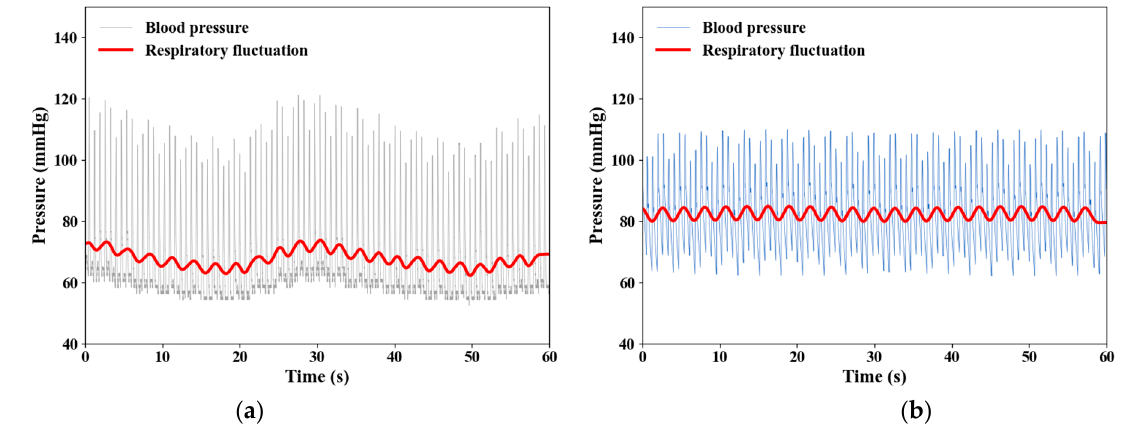
Figure 4. Comparison of RF waveforms between ( a ) clinical measurements and ( b ) 0-1D hemody- namic model-based simulations (subject: 12-year-old, VSD).